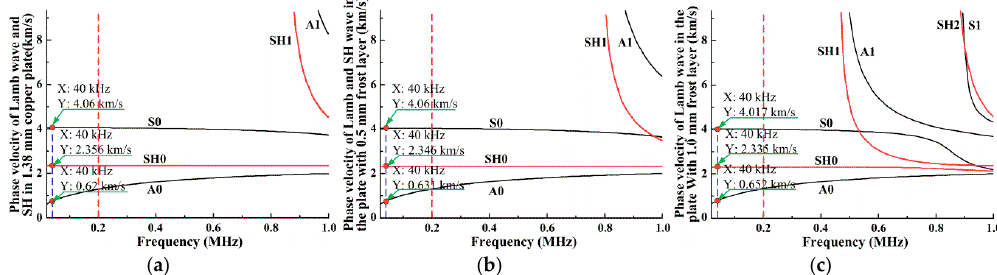
Figure 5. Phase velocities of the Lamb wave and SH wave in a vibration transfer plate with/without a frost layer. ( a ) 1.38-mm-thick copper plate ( b ) plate with a 0.5-mm-thick frost layer ( c ) plate with a 1.0-mm-thick frost layer.